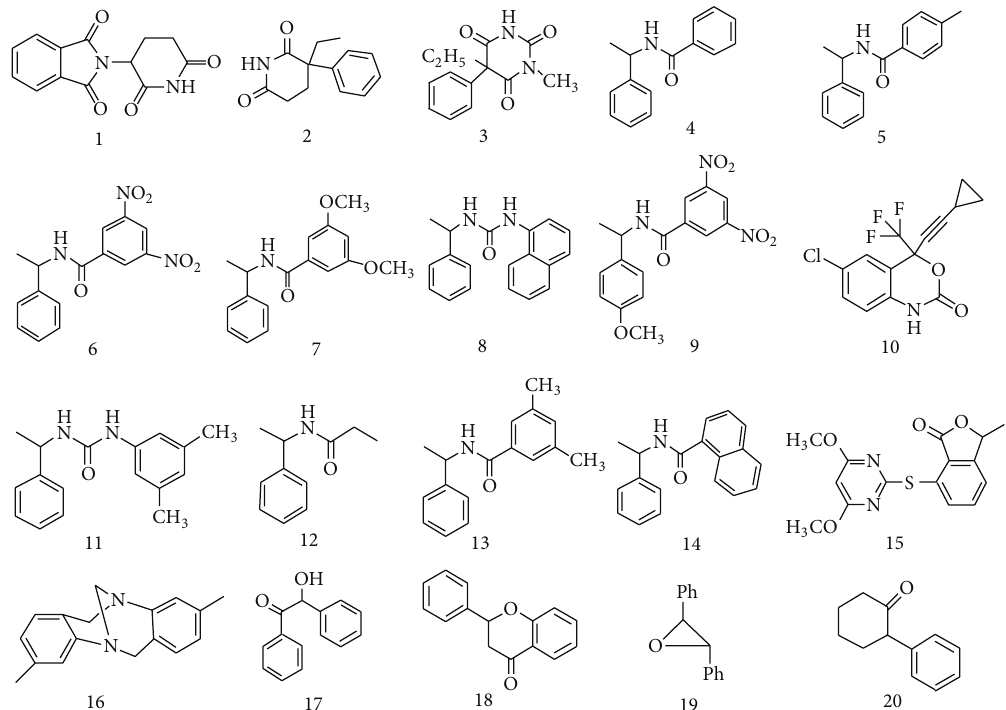
Figure 5: Chemical structures of chiral analytes resolved by CSP 1 and CSP 2 .